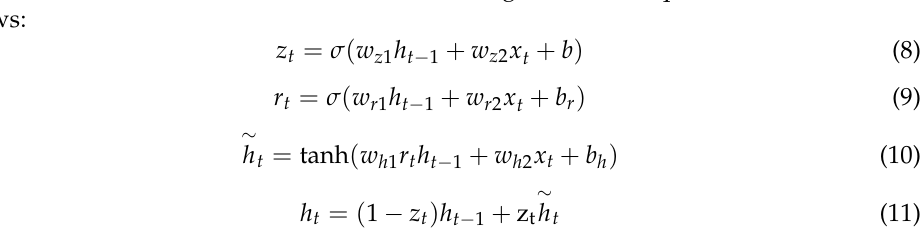
Figure 6. GRU neuron structure.